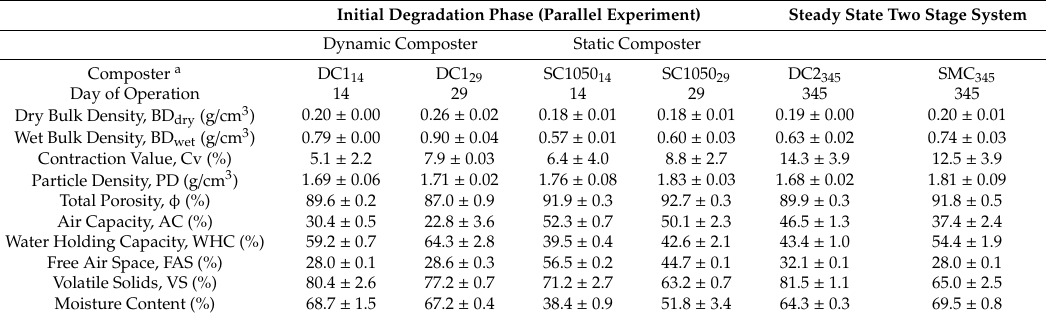
Table 4. Physical parameters of samples from dynamic and static